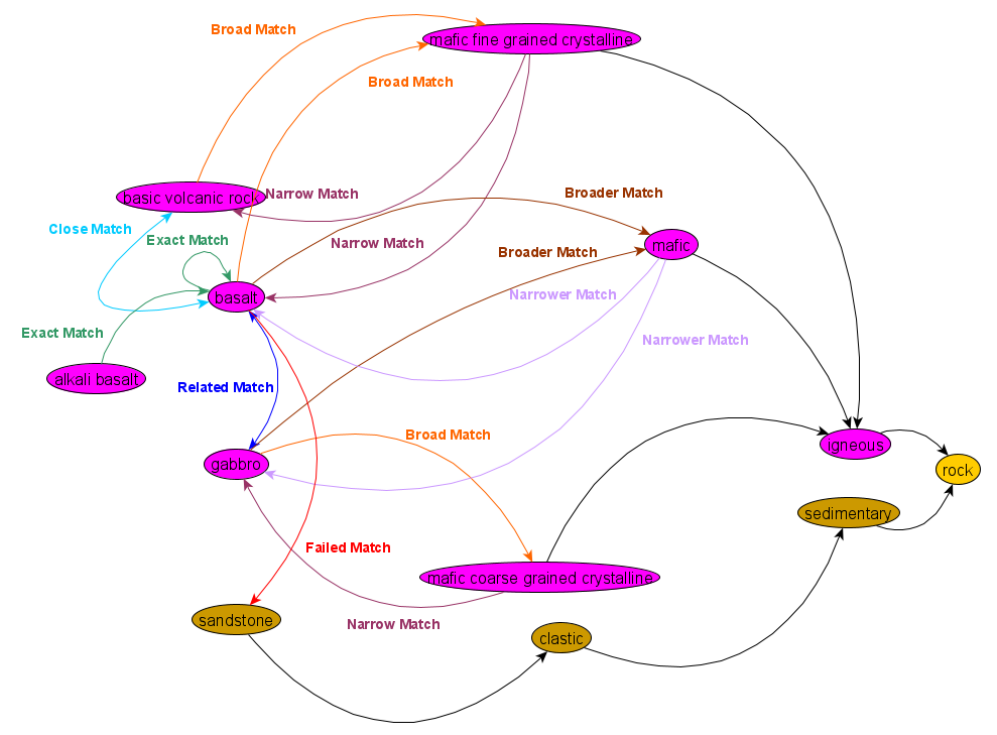
Figure 3. SKOS graph showing the semantic, associative and hierarchical relationship in the Lithology Hierarchical Thesaurus. In this example, the terms “basalt” and “alkali basalt” are judged to be sufficiently the same to assert an exact match relationship (in green). “Basic volcanic rock” however is considered a close match (in cyan) and “gabbro” a related match (in blue). “Mafic fine-grained crystalline” and “mafic coarse-grained crystalline” are broader concepts and are thus considered a broad match (in orange) with “basalt” and “gabbro”, respectively. Broader match (in brown) is similar to broad matches but is used to refer a wider semantic difference between the two concepts. Narrow matches (in light purple) and narrower matches (in dark purple) are the logical equivalent of broad match and broader match. Failed matches is used to describe unrelated